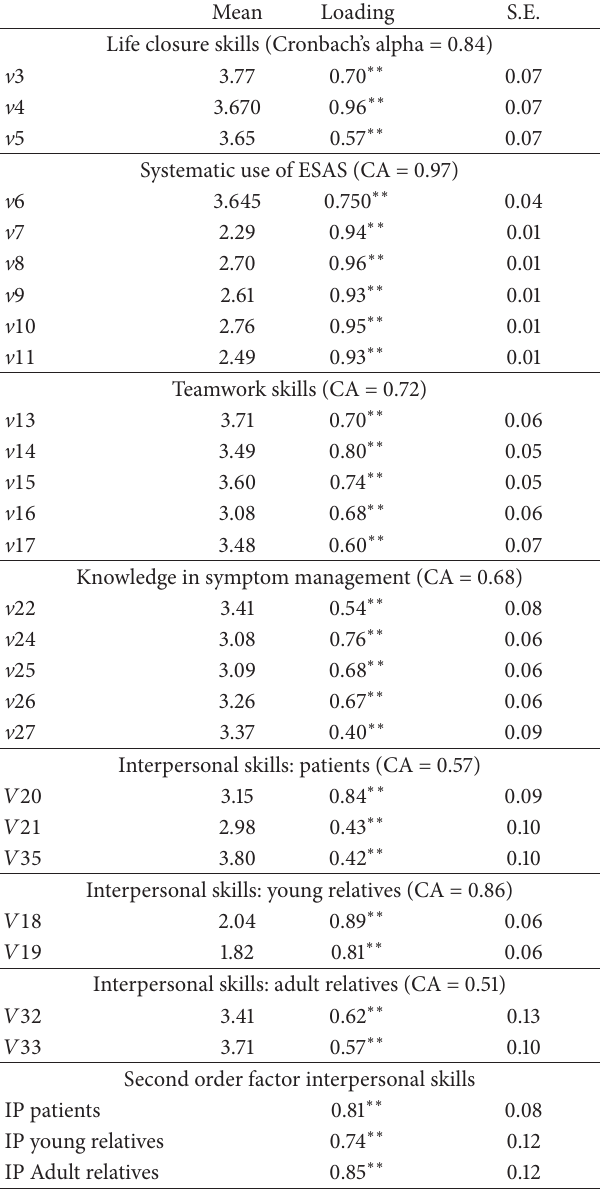
Table 2: Internal consistencies of the latent variables and means, loadings and standard error of the items from analysis ( 𝑁 = 122 , chi-square = 378, d.f. = 283, CFI = 0.95, RMSEA = 0.05, and SRMR =